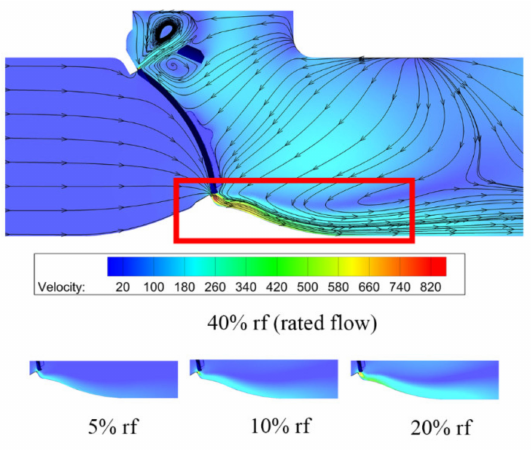
Figure 9. Velocity distributions under di ff erent mass flow rates.